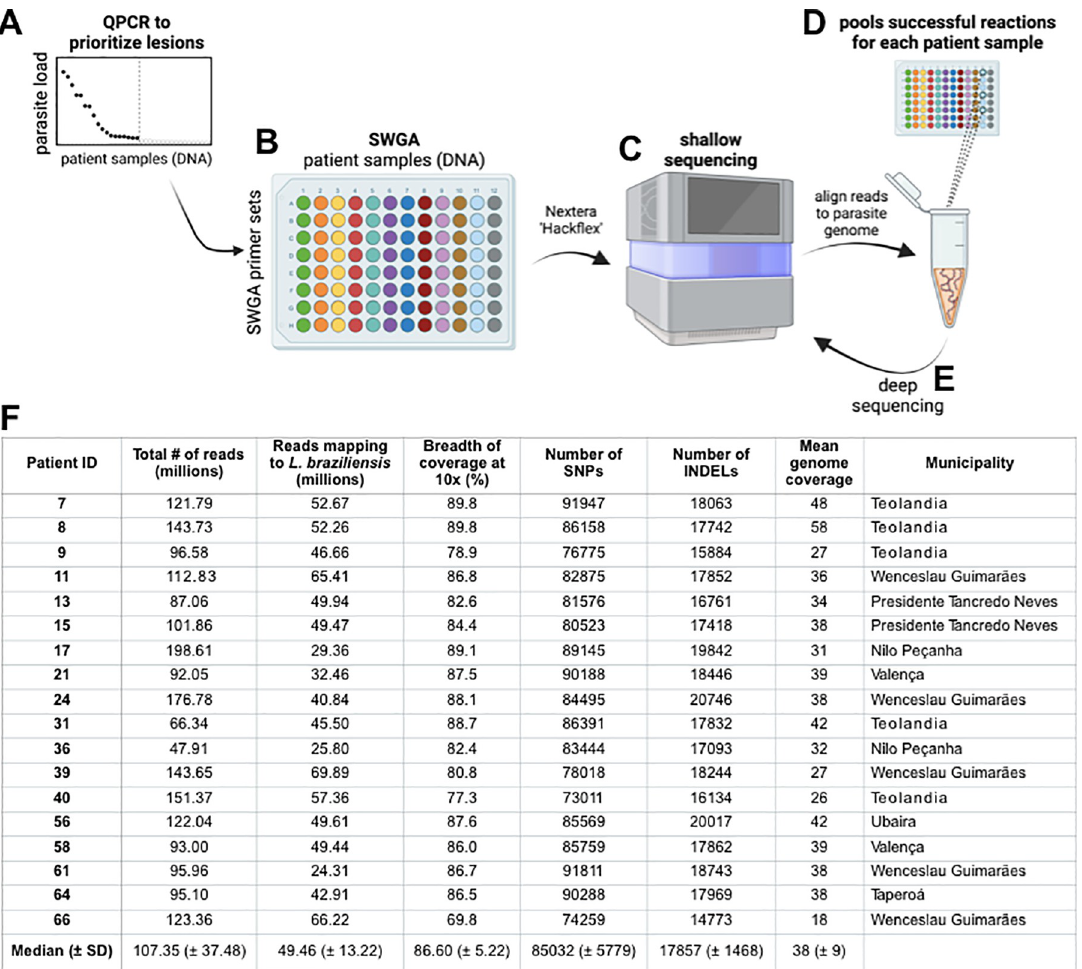
Fig 4. Scalable SWGA profiling of patient samples. (A) QPCR is used to prioritize samples that have the highest parasite burden and, therefore, the greatest likelihood of success for SWGA. (B) SWGA is carried out in 96-well plates using multiple primer sets and primer set combinations (plate rows) for each patient (plate columns). (C) Shallow sequencing is used to determine which samples showed the best amplification by SWGA. (D) All successful SWGA reactions are pooled for each patient and (E) subjected to deep sequencing. (F) Results of selective whole genome amplification of L . braziliensis from 18 primary patient